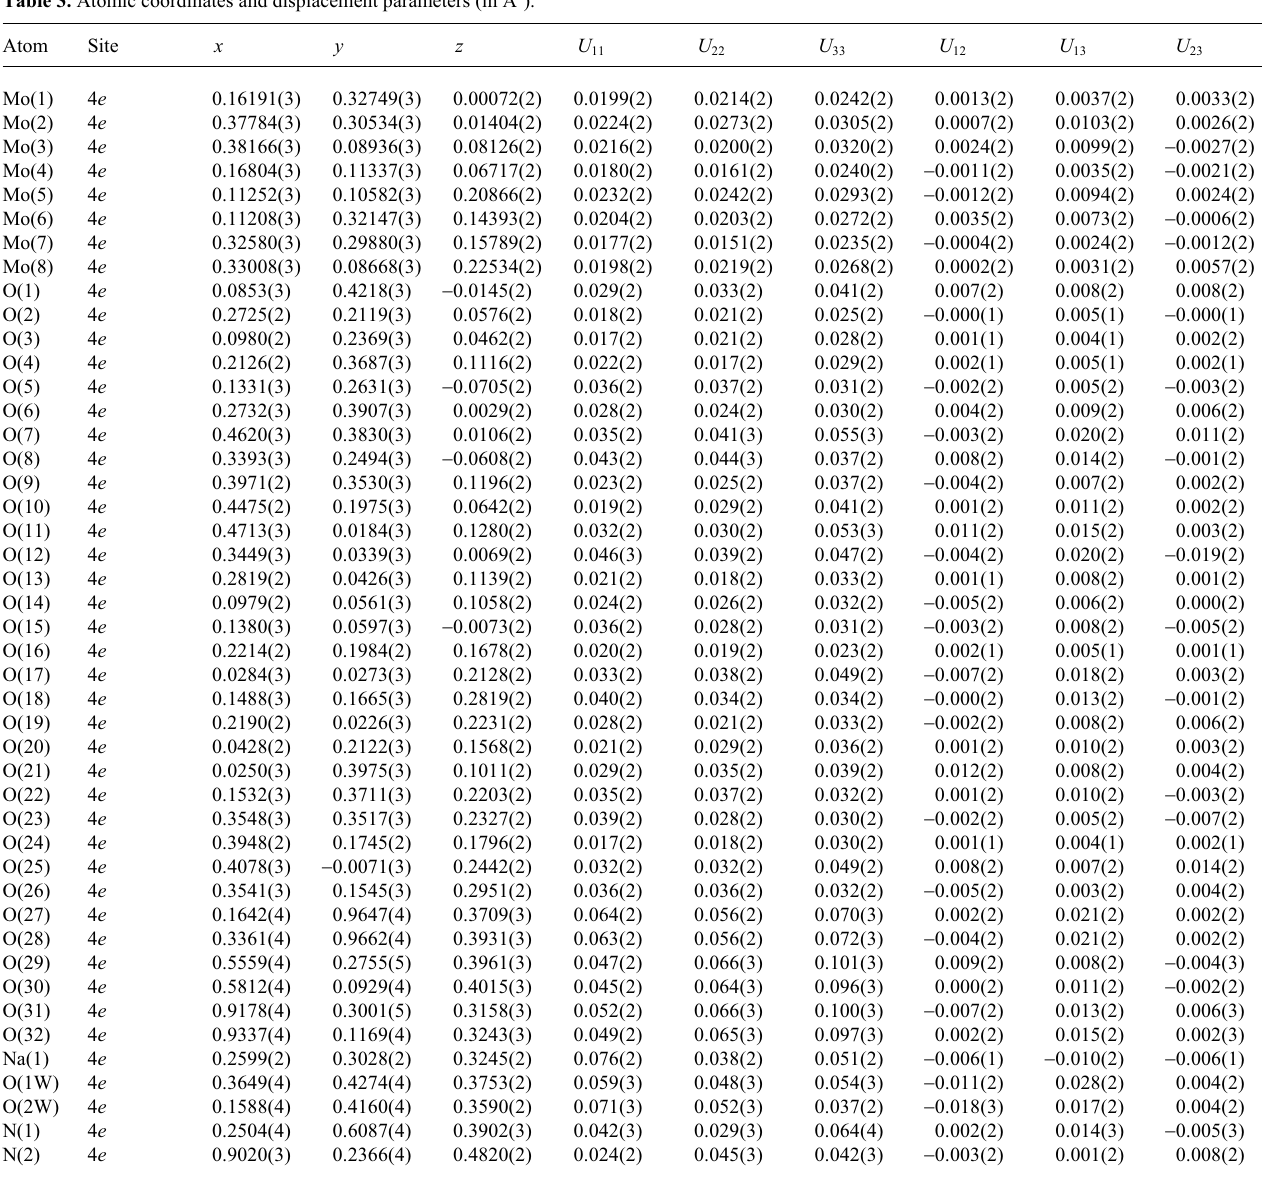
Table 3. Atomic coordinates and displacement parameters (in Å 2 ).